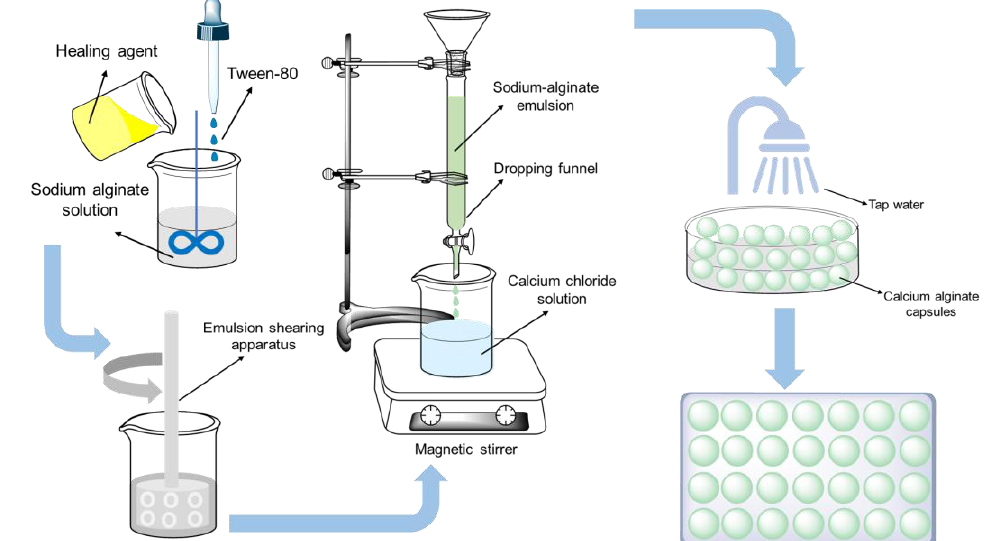
Figure 1. The fabrication procedure of calcium alginate